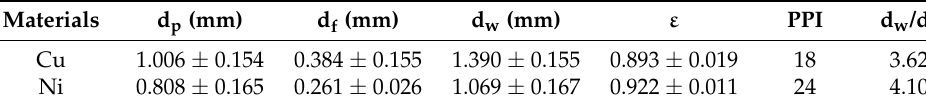
Figure 1. Image ( a ) and SEM image ( b ) of 18 PPI copper metal foam. Table 1. Geometric parameters of specimens.